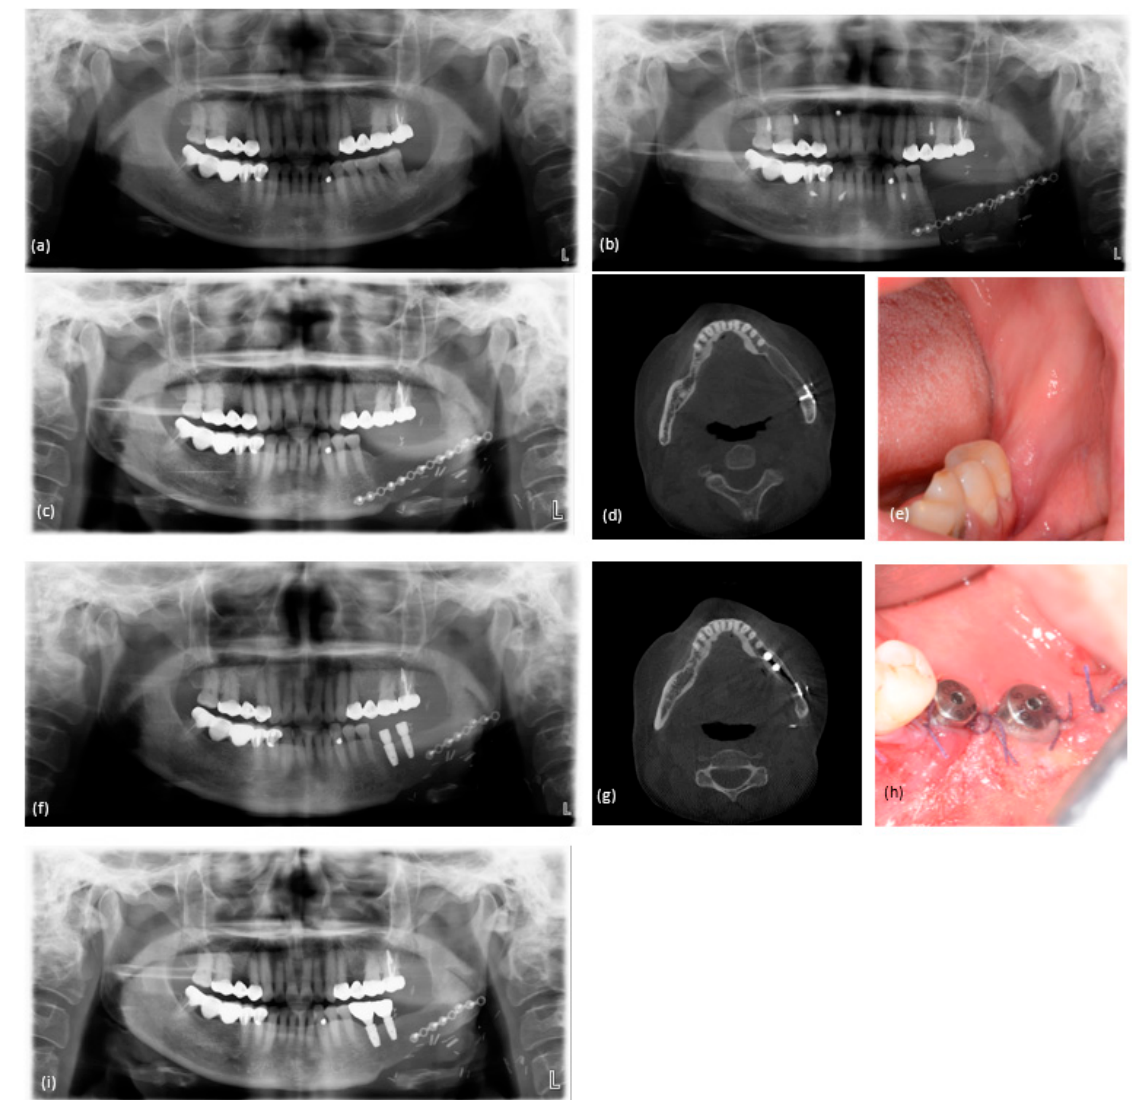
Figure 2. ( a ) Preoperative radiographic panoramic radiograph. ( b ) Postoperative panoramic radiograph after reconstruction using DCIA flap. ( c , d ) Panorama and CT image 6 months after reconstruction. ( e ) Intraoral photo before implant placement. ( f , g ) Radiographic control at the time of implant placement. ( h ) Intraoral photo at the time of implant placement. ( i ) After delivery of prosthesis.